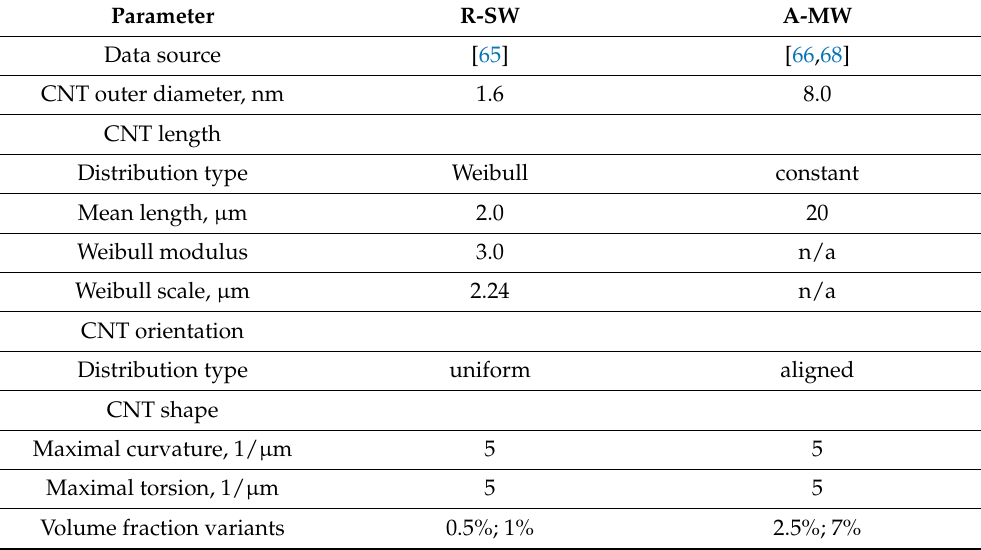
Table 1. Parameters of the modelled CNT